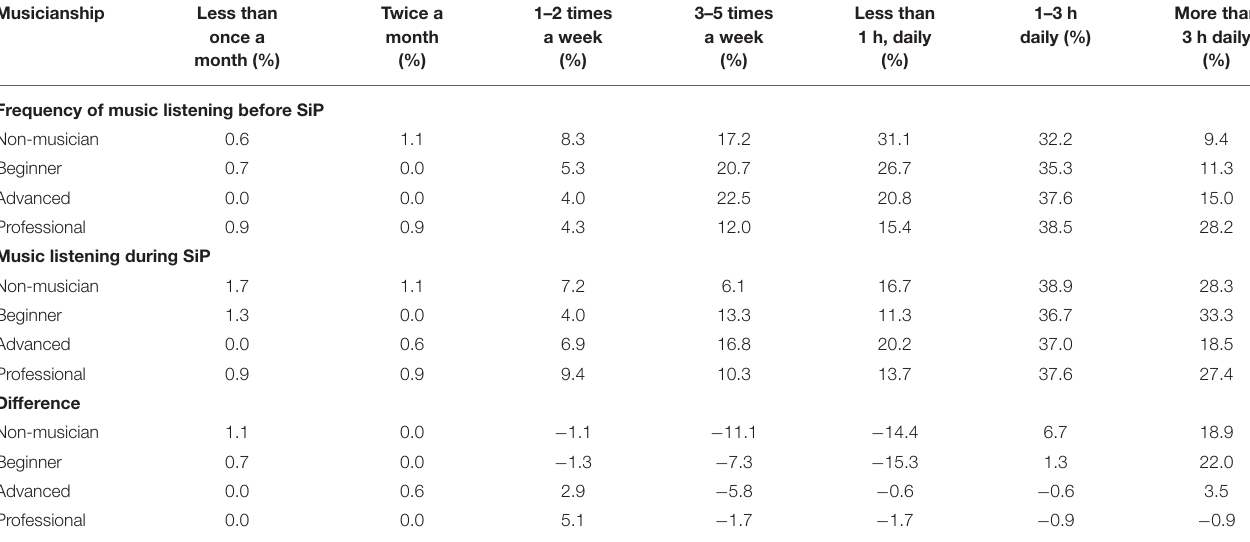
TABLE 17 | Distribution of music listening frequency before and during SiP (shelter-in-place) grouped by musicianship.